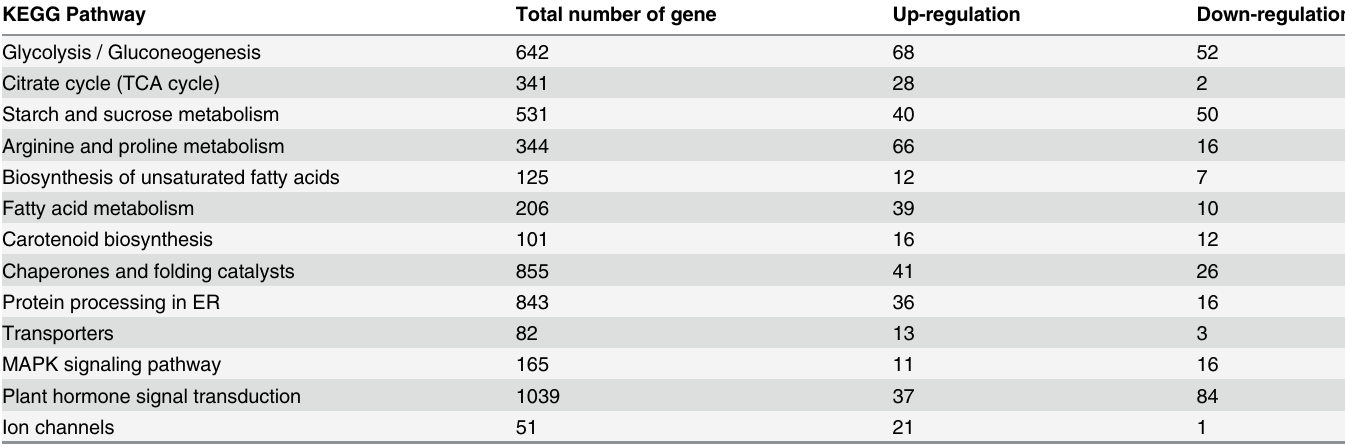
Table 2. The expression behaviors of the related genes in KEGG pathways. KEGG